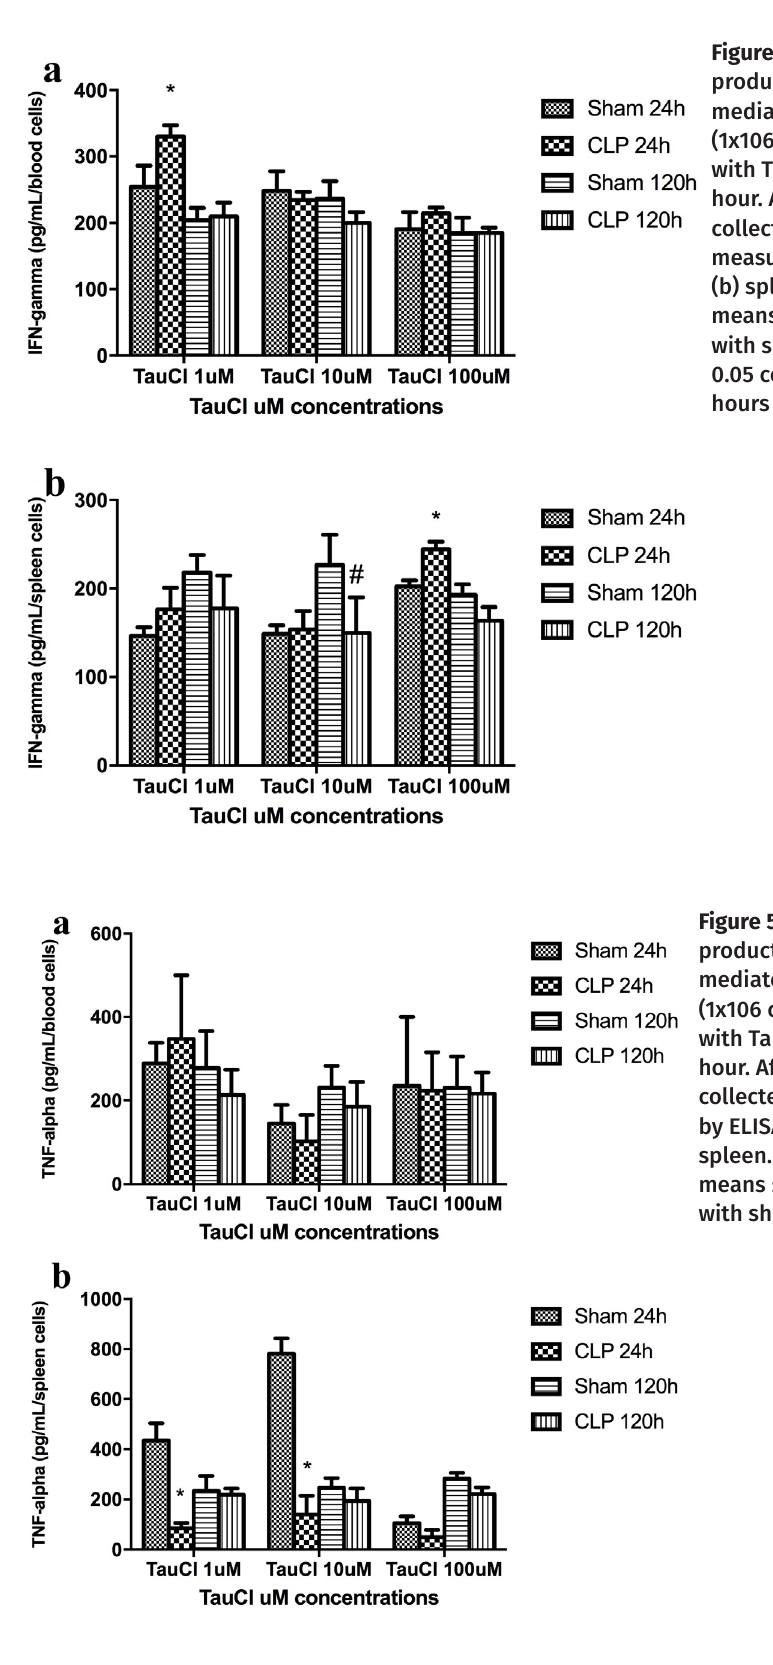
Figure 4. The effect of TauCl on the production of the pro-inflammatory mediator, IFN-gamma. Lymphocytes (1x106 cells/mL) were preincubated with TauCl (1, 10 or 100 uM) for 1 hour. After this, supernatants were collected and IFN-gamma was measured by ELISA for (a) blood and (b) spleen. Results are expressed as means ± SD. * = P < 0.05 compared with sham rats at 24 hours. # = P < 0.05 compared with sham rats at 120 hours (n=5).